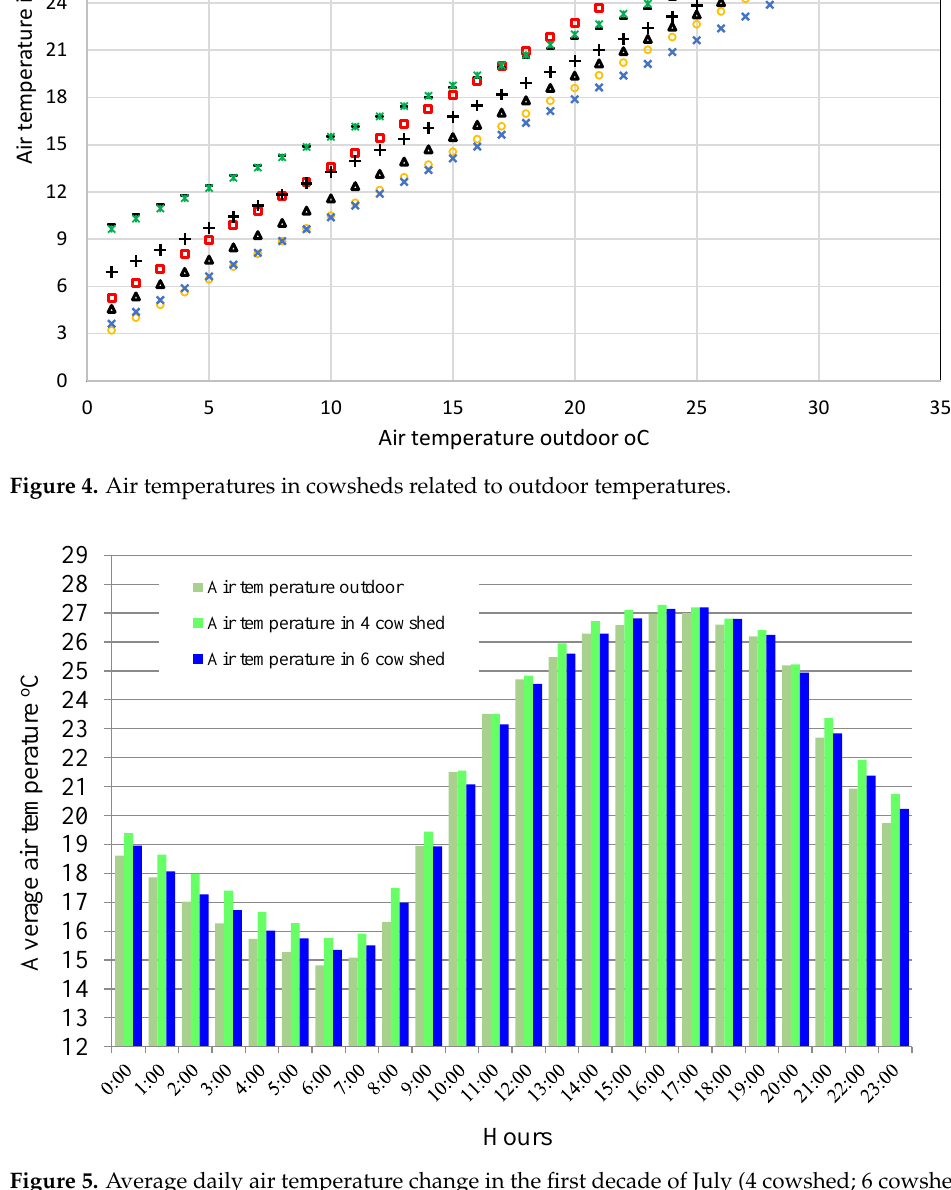
Figure 5. Average daily air temperature change in the first decade of July (4 cowshed; 6 cowshed).